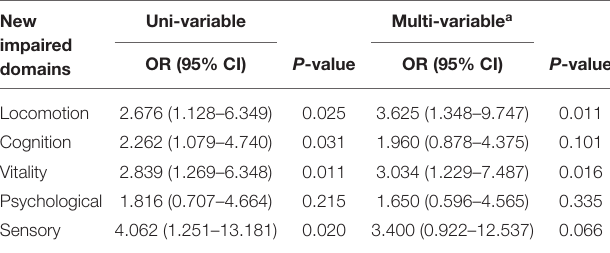
TABLE 3 | Logistic regression analysis showing the correlation between new impaired domains and frailty status transitions in non-frail older